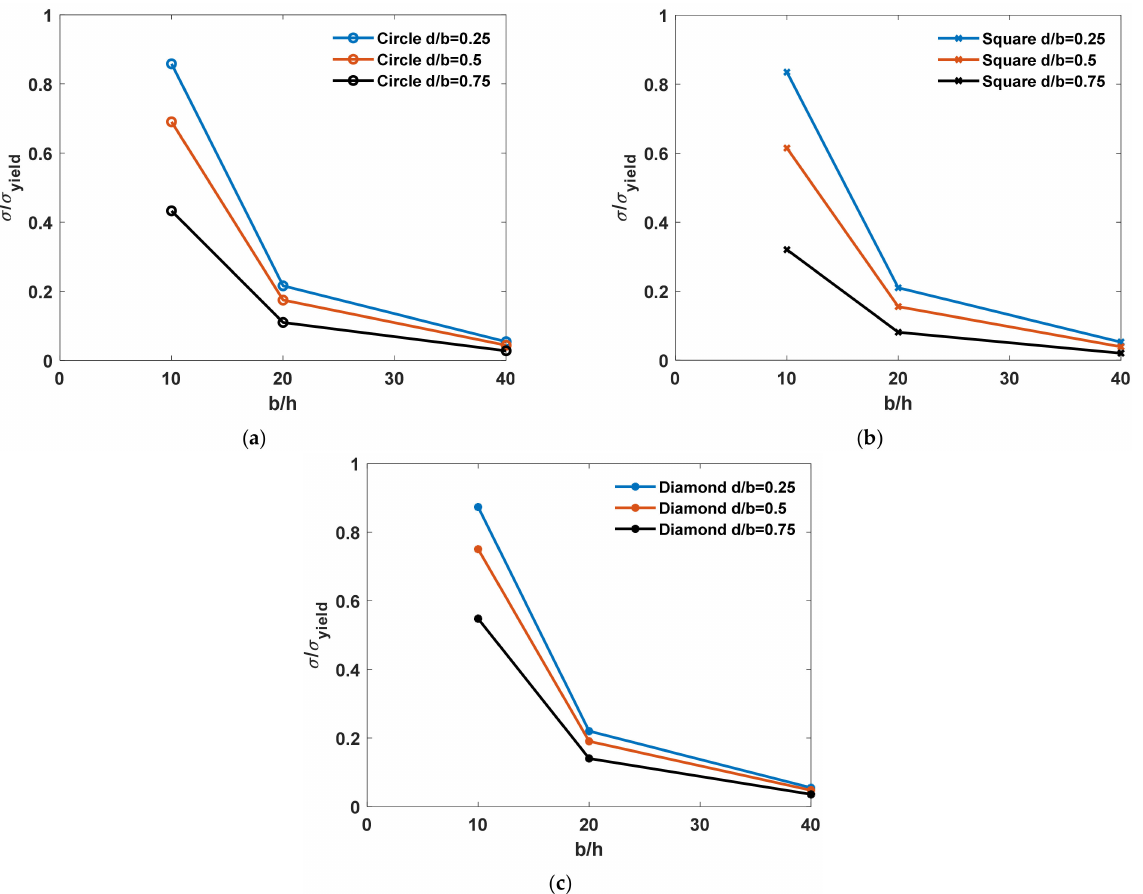
Figure 15. The variation of the aspect ratio on the normalized stress ratio for ( a ) circle, ( b ) square, and ( c ) diamond